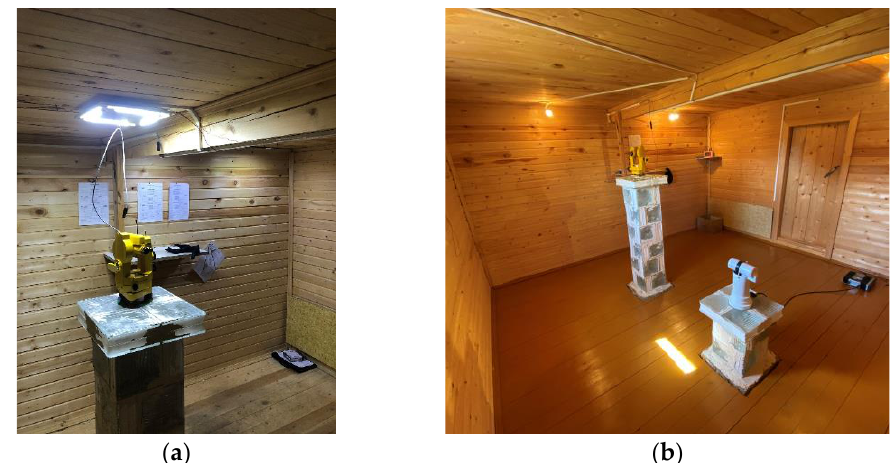
Figure 6. Lighting in the absolute pavilion of the Klimovskaya magnetic observatory: ( a ) a LED set installed in October 2018; ( b ) halogen light bulbs installed in December 2018. The increased scatter of the D values corresponding to the period of measurements using LED lighting is seen even in Figure 7a; however, for a proper analysis, the D time series was detrended and plotted in Figure 7b. (the linear trend, excluded from the absolute D values for scatter analysis, is shown in Figure 7a with a red dashed line). Vertical purple dashed lines show the periods when the lighting in the pavilion was changed.